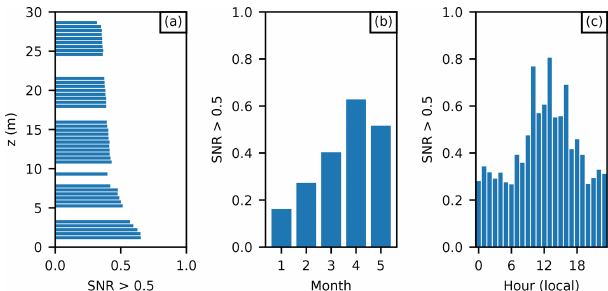
Figure 5. Fraction of the data preserved (i.e. that fulfil the SNR > 0 . 5 threshold) as functions of (a) the height, (b) the month, and (c) the hour of day in local time (EET/EEST). Note that January and May only contain data from 5d.